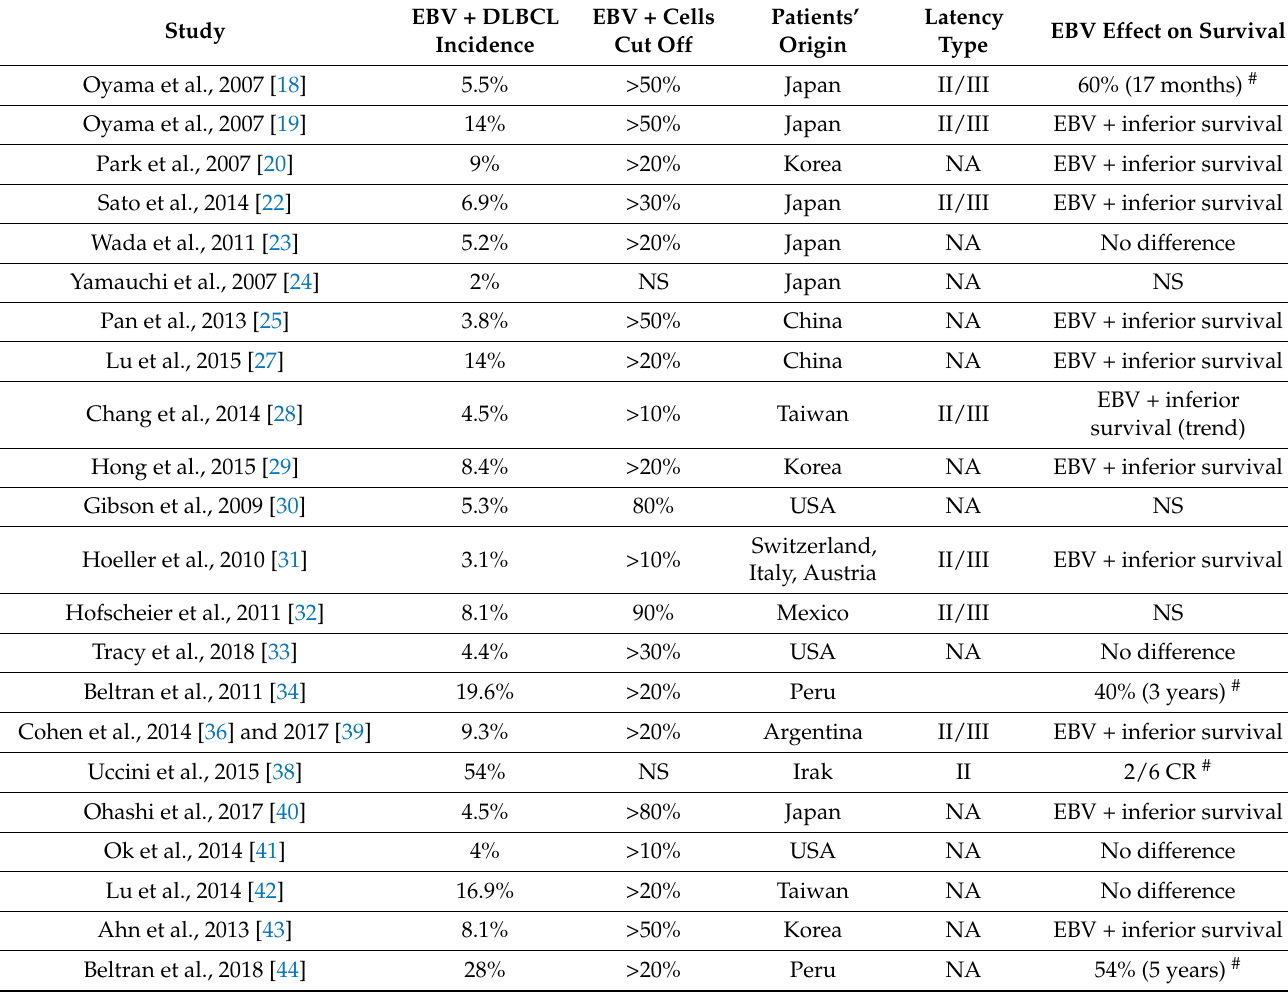
Table 1. EBV + DLBCL in different